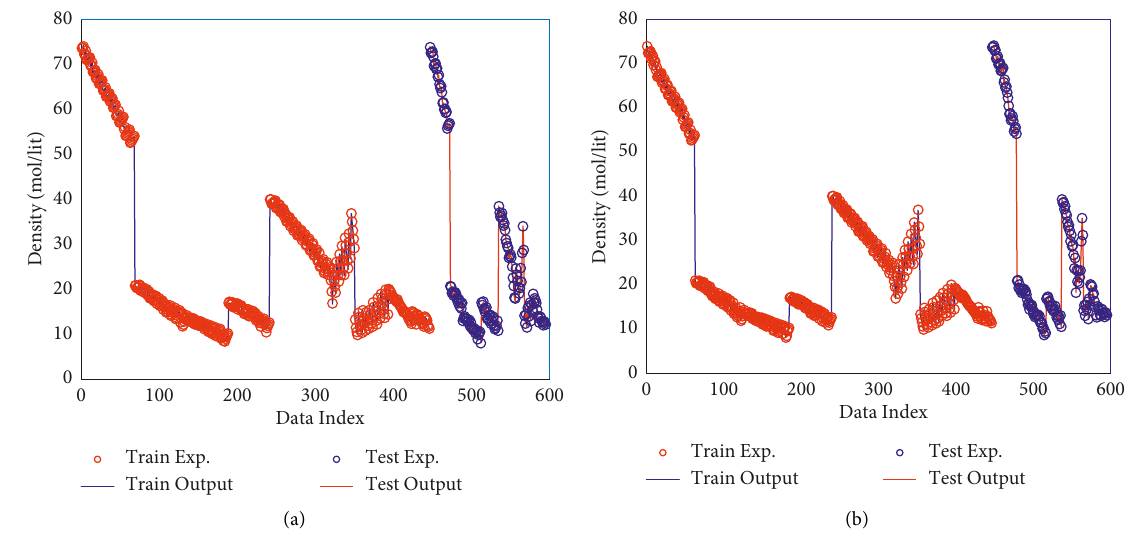
Figure 9: Simultaneous demonstration of predicted and experimental alkali metal densities for (a) ANFIS and (b)